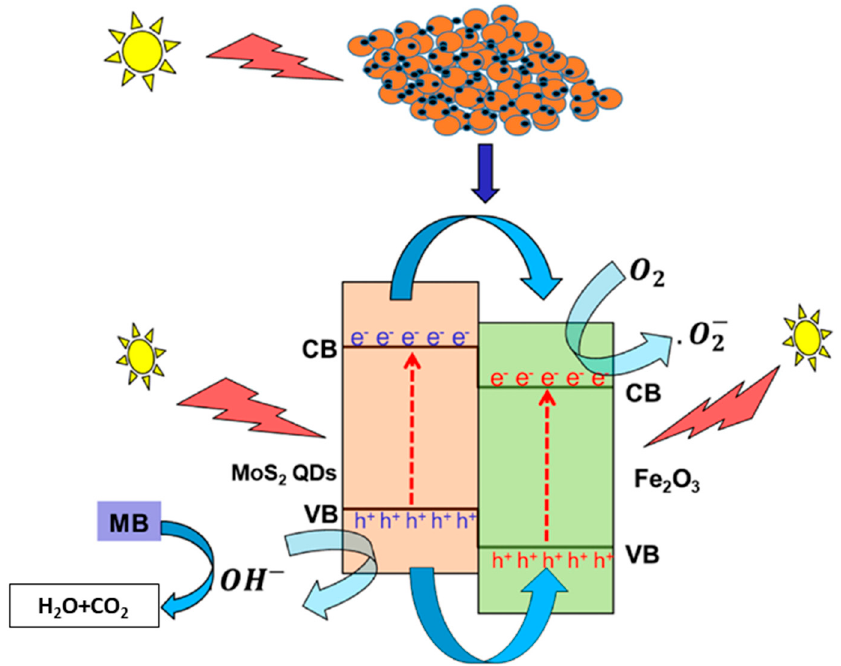
Figure 4. Schematics of the proposed photocatalysis mechanism of α -Fe 2 O 3 /MoS 2 QDs. Reproduced from [92], with permission from John Wiley & Sons. Copyright 2018 Wiley-VCH GmbH.